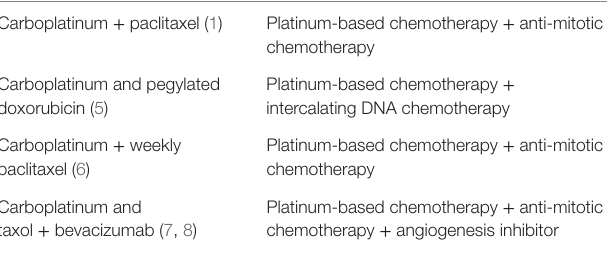
Table 1 | Front-line treatment for ovarian cancer